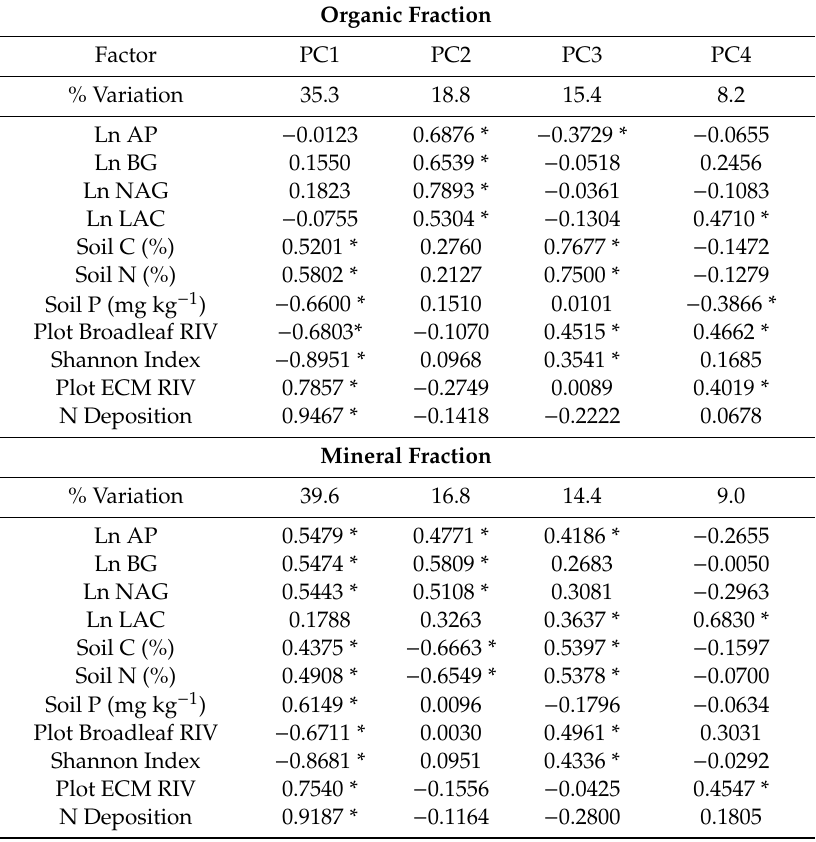
Table 3. Principle component loadings for soil-level and plot-level factors, ESE activities, and N deposition in high elevation red spruce forests. ESE activities were natural log transformed. Values marked with * contribute disproportionately to the PC